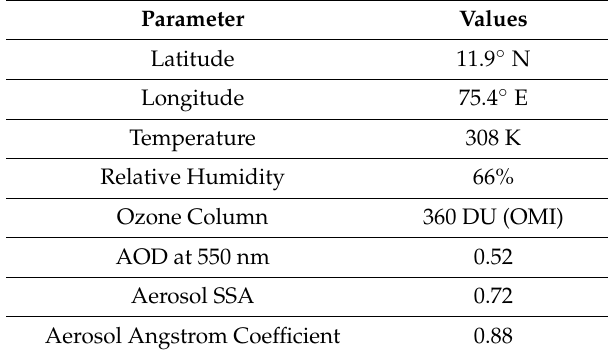
Table 2. Environmental parameters opted for the box model simulations.